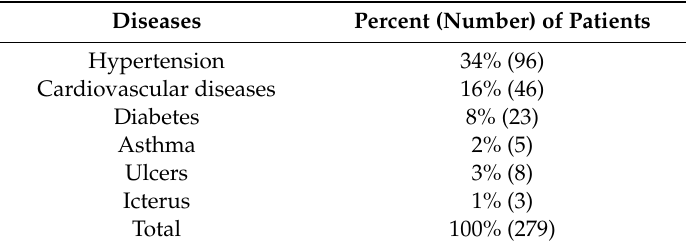
Table 1. The general health of patients.